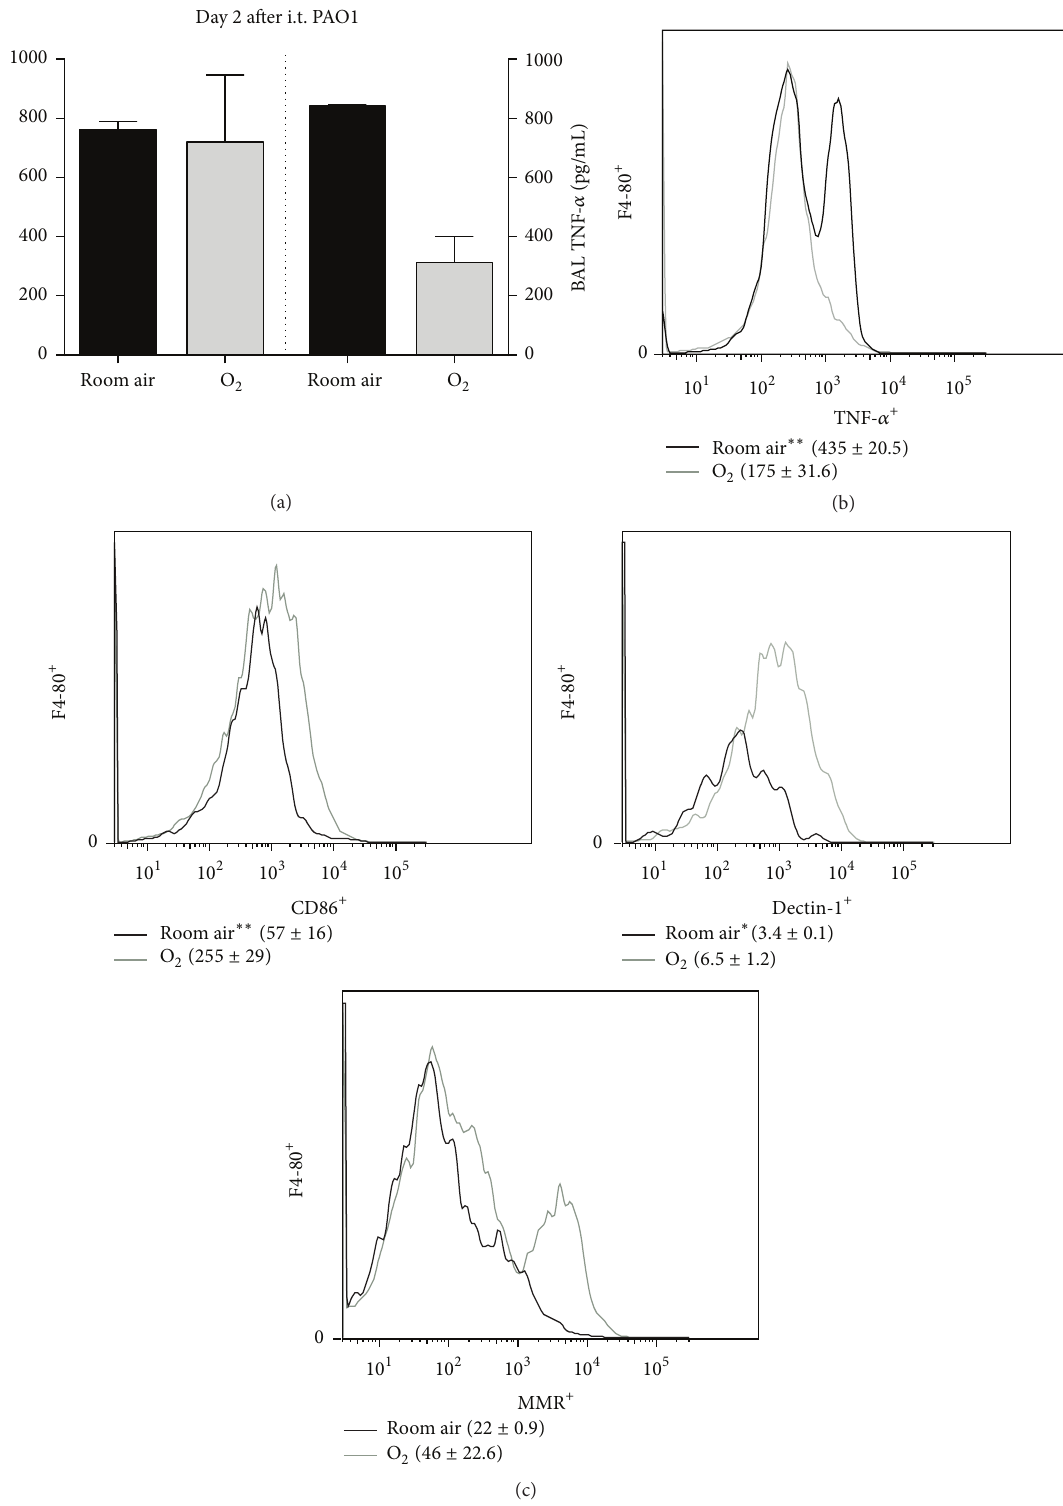
Figure 2: Oxygen alters the inflammatory profile and alveolar macrophage phenotype in CS and i.t. PAO1-exposed mice. (a) BAL cytokines were quantified following 2 days of PAO1 exposure in CS-exposed mice ( 𝑛 = 2 –4). (b) Representative histogram of the mean fluorescent intensity (MFI) of expression of intracellular TNF- 𝛼 using FACS among BAL F4-80 + macrophages ( ∗∗ 𝑝 < 0.01 by unpaired 𝑡 -test; MFI ± SD, 𝑛 = 3 ). (c) Representative histogram of the MFI of the surface markers CD86, Dectin-1, and MMR on BAL F4-80 + macrophages ( ∗ 𝑝 < 0.05 , ∗∗ 𝑝 < 0.01 by unpaired 𝑡 -test; MFI ± SD, 𝑛 = 3